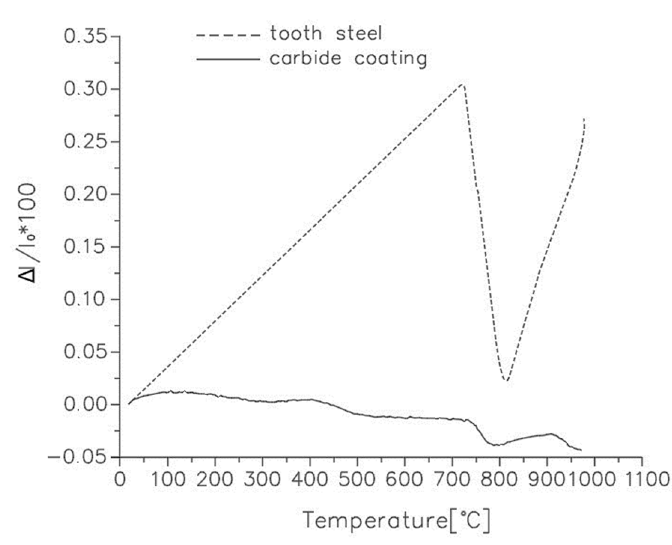
Figure 9. Dilatometric curves of the substrate steel and the coating.